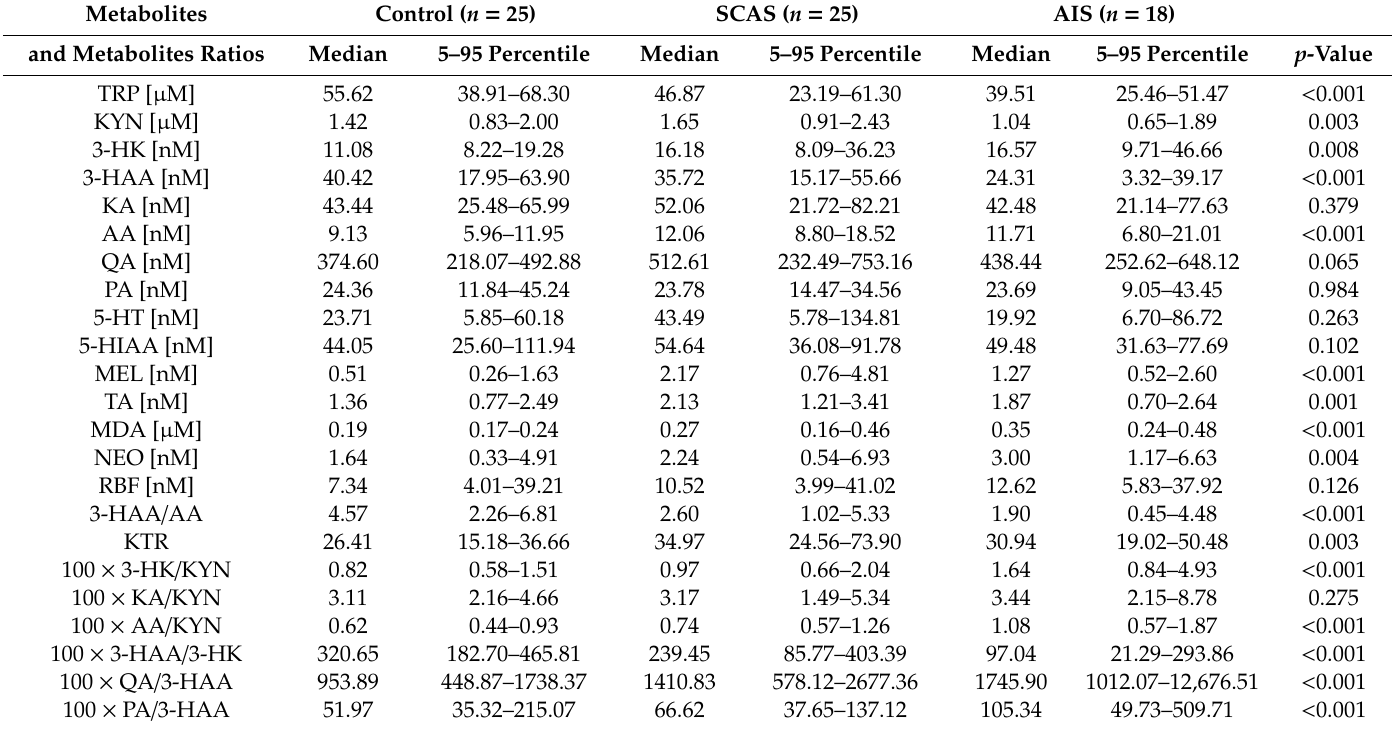
Table 1. Plasma concentrations of TRP metabolites, NEO, MDA, RBF, and some significant metabolite